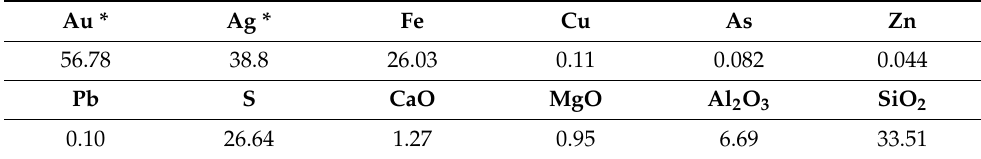
Table 1. Main chemical components of the test sample